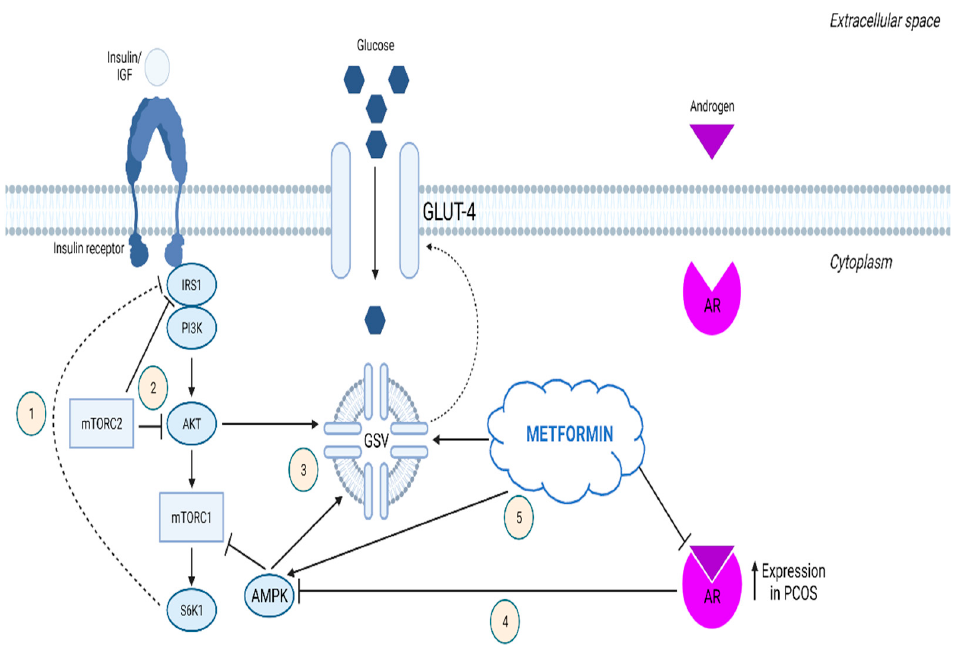
Figure 2. mTOR signaling in PCOS-induced endometrial hyperplasia Glucose metabolism in the uterus is of essential importance for normal endometrial function. Hyperinsulinemia and insulin resistance are major disorders involved in the pathogenesis of PCOS and are believed to contribute to the development of EH in women with this condition. (1) Normally, S6K1 phosphorylates IRS1, thereby preventing the association of IRS1 with the insulin receptor. This negative feedback mechanism desensitizes and protects the cell from further insulin stimulation. When mTORC1 is chronically activated, for example, due to excessive glucose consumption, the sustained downstream stimulation of S6K1 increases IRS1 phosphorylation. This decreases its responsiveness to insulin, thus rendering the cell insulin resistant [109]. (2) mTORC2 influences insulin sensitivity by impairing IRS1 and AKT function. (3) GLUT-4 expression and translocation to the plasma membrane are enhanced by AMPK and AKT, respectively [109,117]. (4) High androgen levels in PCOS restrain apoptosis and increase the proliferative potential of endometrial cells by stimulating mTOR signaling via AMPK inactivation. (5) Metformin restrains EH by suppressing the mTOR pathway through AMPK stimulation. It has also been shown that metformin increases GLUT-4 and decreases AR levels in the endometrium, probably via the mTOR pathway [118]. IGF, insulin-like growth factor; IRS1, insulin receptor substrate 1; PI3K, phosphatidylinositol-3-kinase; AKT, protein kinase B; mTORC2, mammalian target of rapamycin complex 2; mTORC1, mammalian target of rapamycin complex 1; S6K1, p70S6 kinase 1; AMPK, adenosine monophosphate (AMP)-activated protein kinase; GLUT-4, glucose transporter type 4; GSV, GLUT-4 storage vesicle; AR, androgen receptor3. Graphic created with BioRender.com.